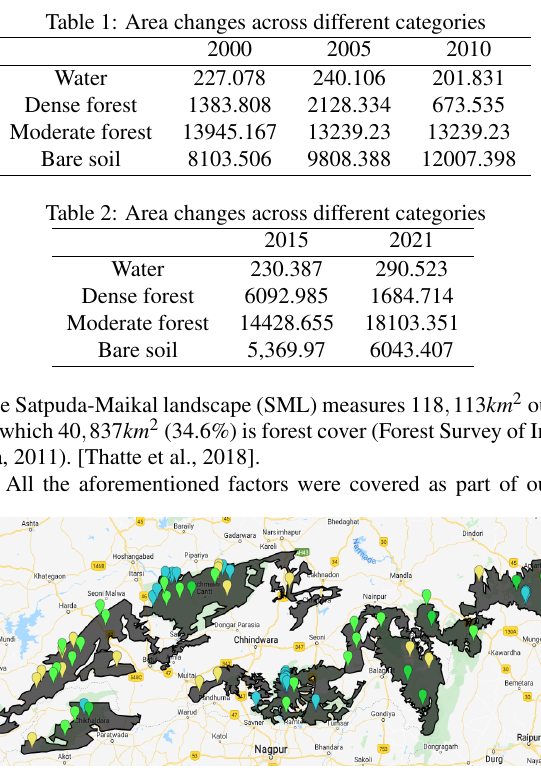
Figure 5: Reference points, for training and